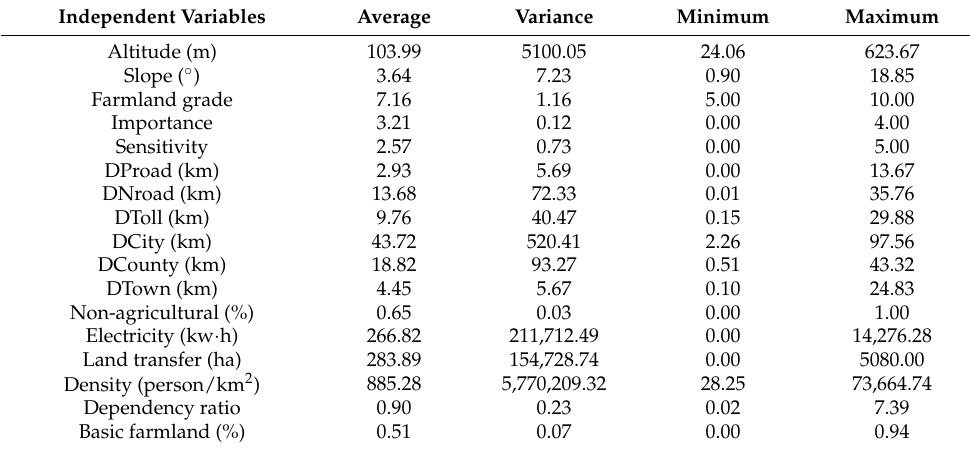
Table 2. Independent variables comprising the statistical